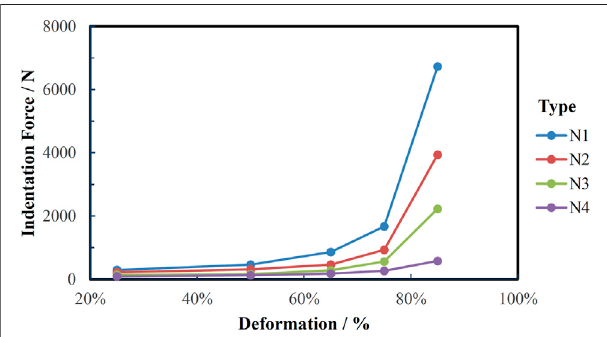
FIGURE 2 | The indentation force of the experimental cushions under different deformation.